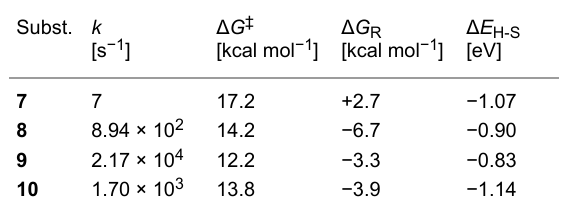
Table 4: Calculated kinetic and thermodynamic data (on the PW6B95- D3/QZVP//TPSS-D3/def2-TZVP level) and HOMO–SOMO gap Δ E H-S (on the TPSS-D3/TZVP level) of the reactions of 7 – 10 in benzene at 40 °C. Subst. k [s − 1 ]